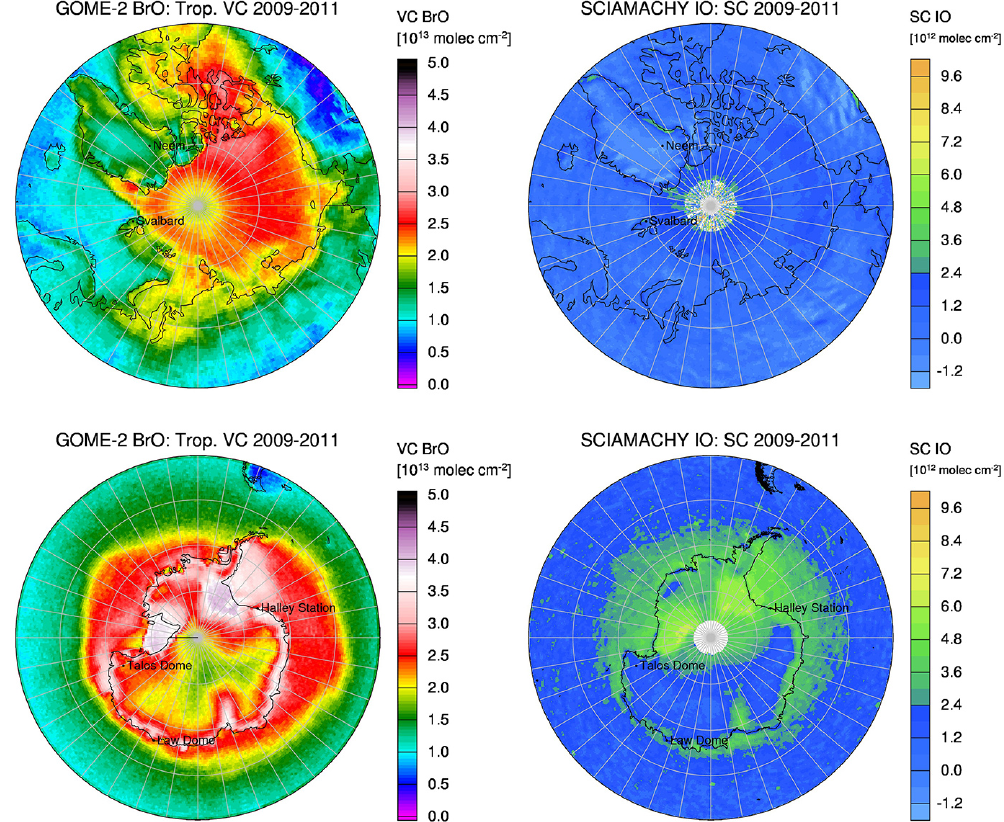
Figure 1. Average atmospheric column amounts of BrO and IO in Antarctica and the Arctic between 2009 and 2011. Bromine and iodine concentrations are greatest above the Antarctic ice shelves and along the coast. In the Arctic, iodine concentrations are near the limit of detection by satellite. Sampling site locations are shown as well as other locations mentioned in the text.